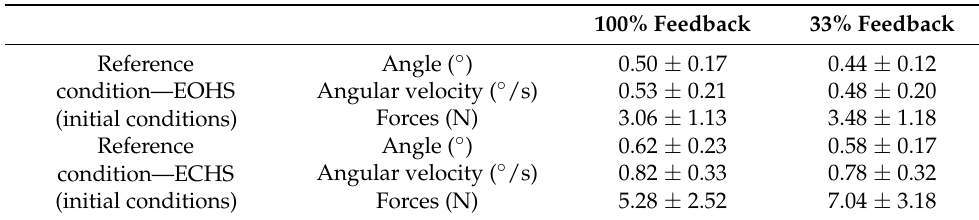
Table A1. Group means ( ± standard deviation) of the ellipse area covering body sway angle, body sway angular velocity, and ground reaction forces for all